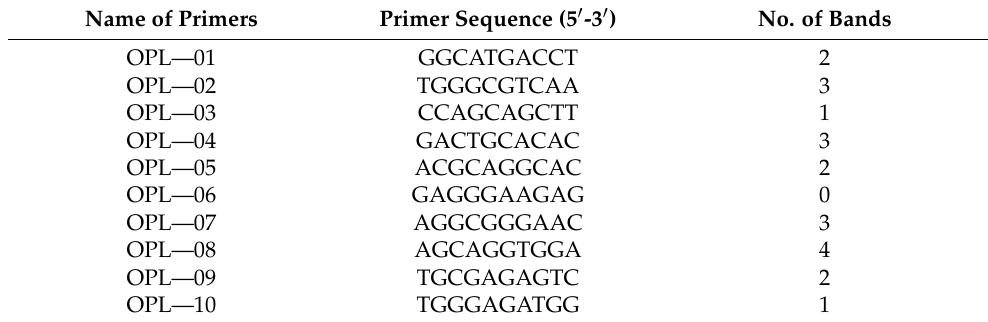
Figure 2. Effect of planting materials on the survival rate (%) of D. plamatus plantlets during acclimation. Bars denoted by the same letter are not statistically different at p = 0.05 . Table 4. Amplified-DNA bands generated from random amplified polymorphic DNA primers in the mother plant and in vitro-propagated plants of D. palmatus